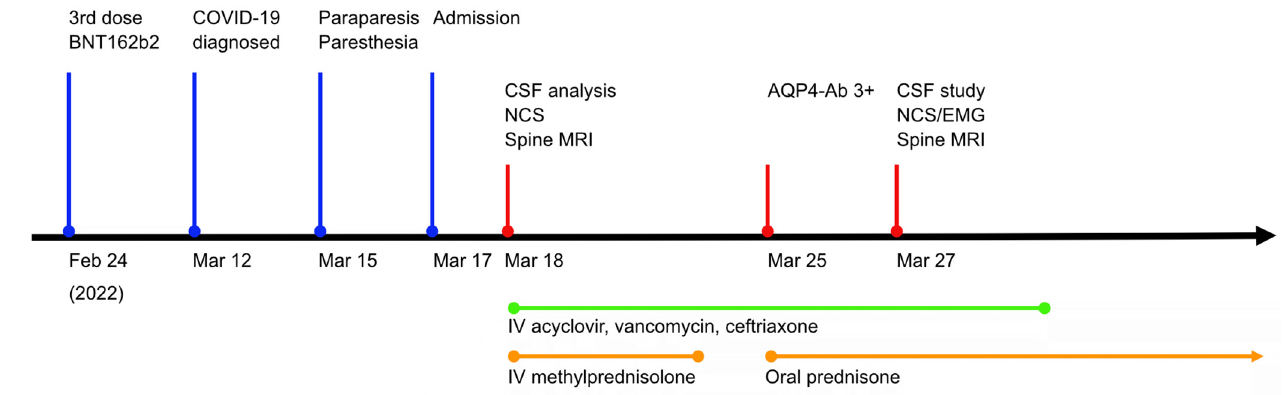
Figure 1. Timeline of clinical date, investigation, and medication. Clinical presentation and administration of proper medication were depicted on the appropriate date. AQP4-Ab, anti-aquaporin 4 antibody; COVID-19, coronavirus disease 2019; CSF, cerebrospinal fluid; NCS, nerve conduction study; MRI, magnetic resonance imaging.